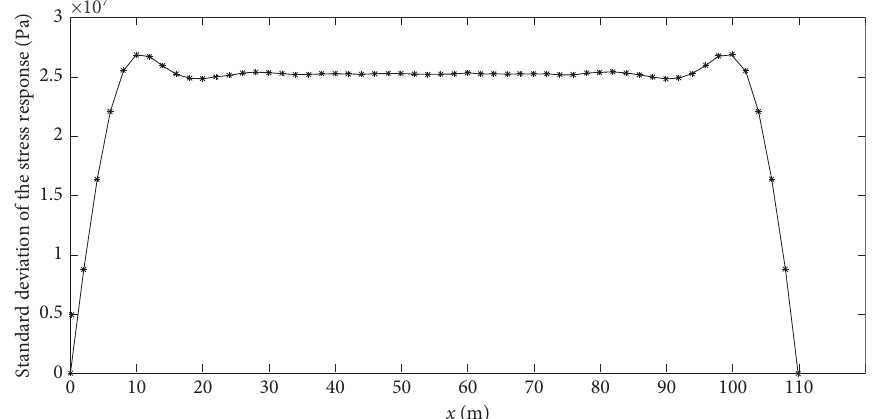
Figure 9: Standard deviation of the stress response with the subsea BOP ( H